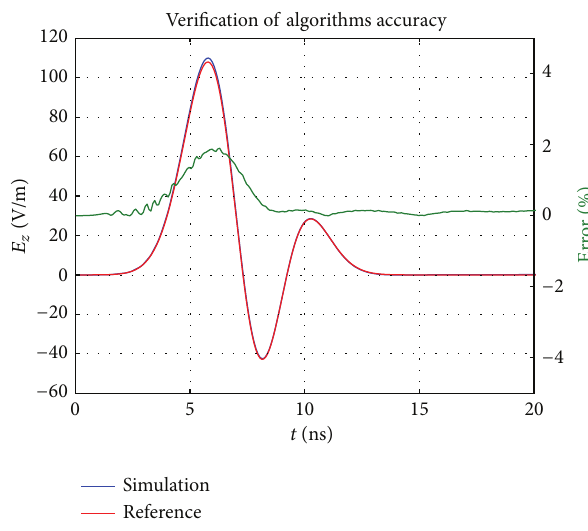
Figure 4: The accuracy verification of cudaFDTD. The green line is relative error using the right 𝑦 axis. Table 2: Statistics of the time consumption of